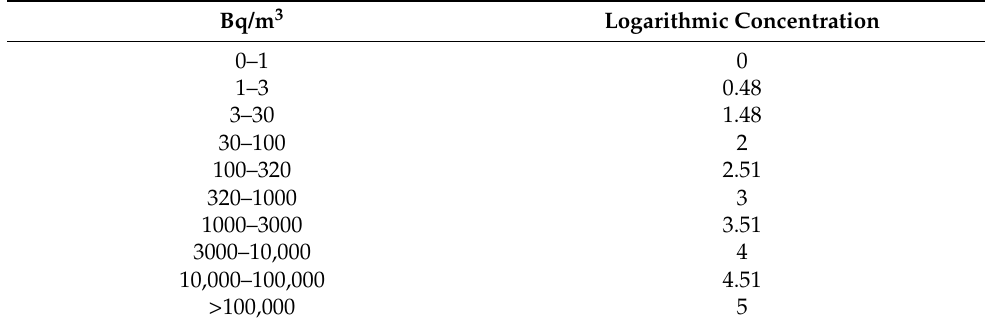
Table 1. Radon concentration grouping.